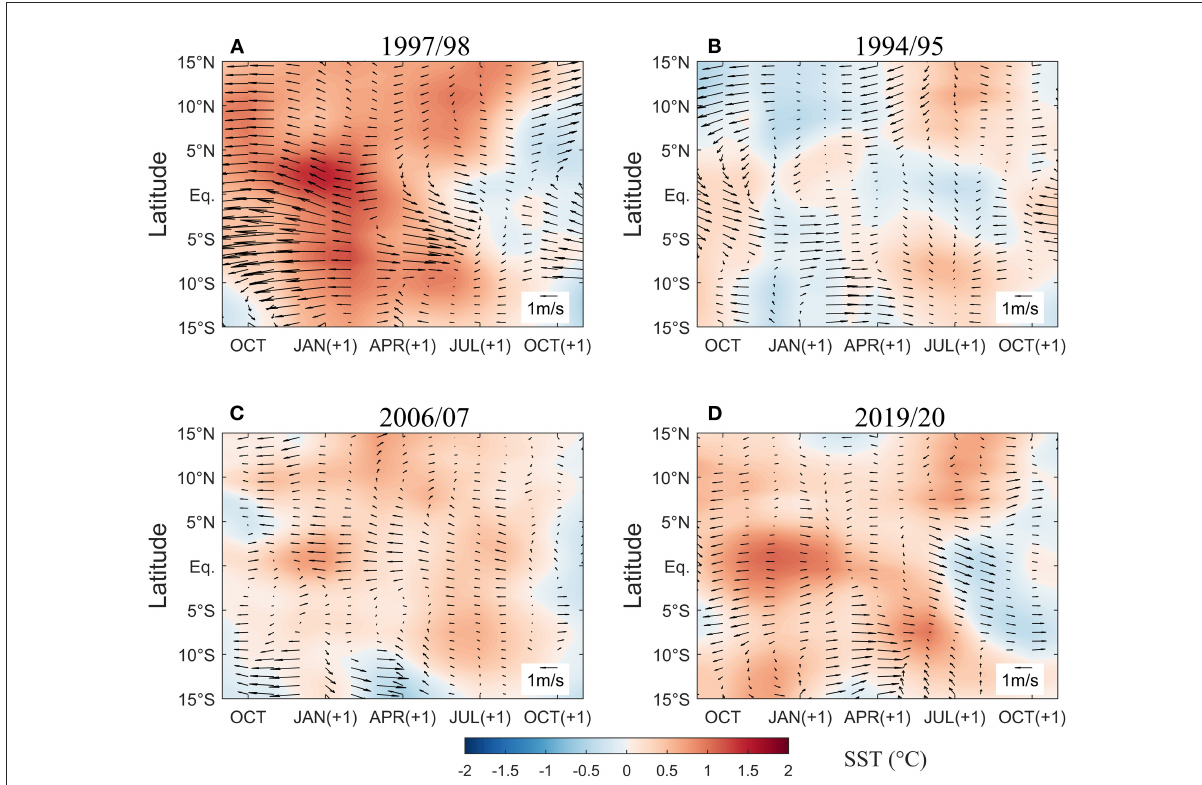
FIGURE9 Time-latitude diagram for sea surface temperature anomalies (shading, ◦ C) and surface wind anomalies (vector, m/s) meridionally averaged over 50-60 ◦ E in the Indian Ocean for four positive IOD events in 1997 (A) , 1994 (B) , 2006 (C) , and 2019 (D) . Data are based on OISST from 1982-2021, CCMP (Atlas et al., 2011; Mears et al., 2019) wind from 1988-2021. Linear trends and seasonal cycles are removed based on each period coverage.